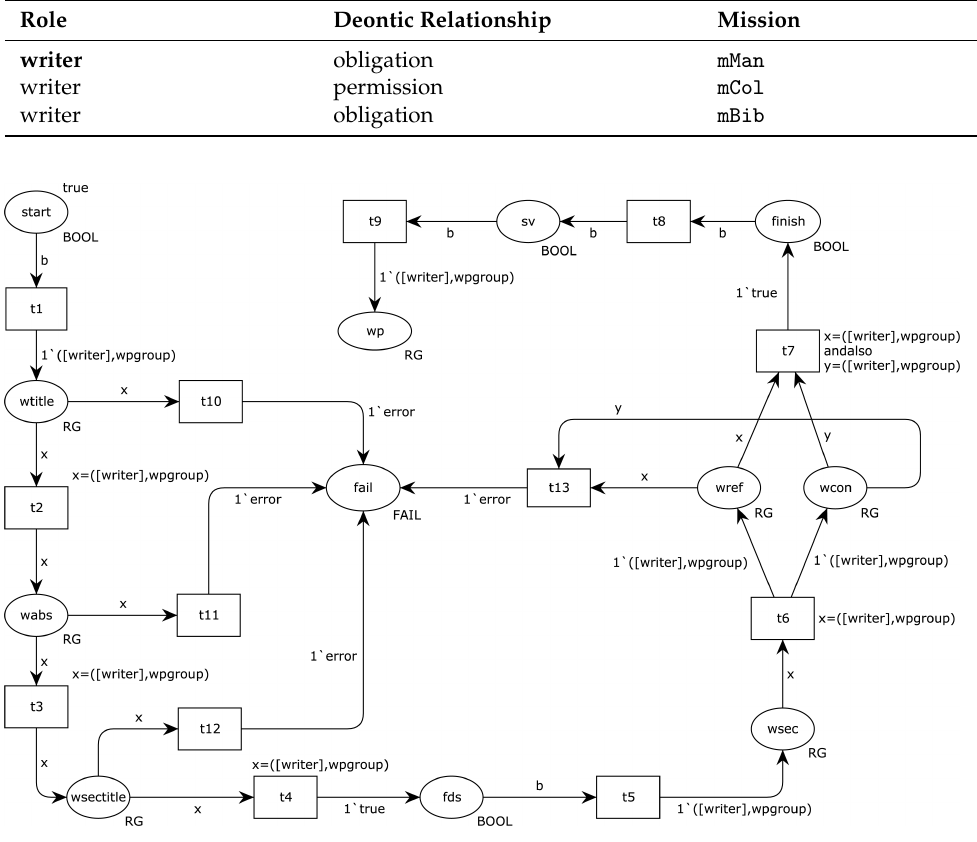
Figure 18. The CPN4M for Writing Paper error example—obligation for an agent not eligible for the plan.